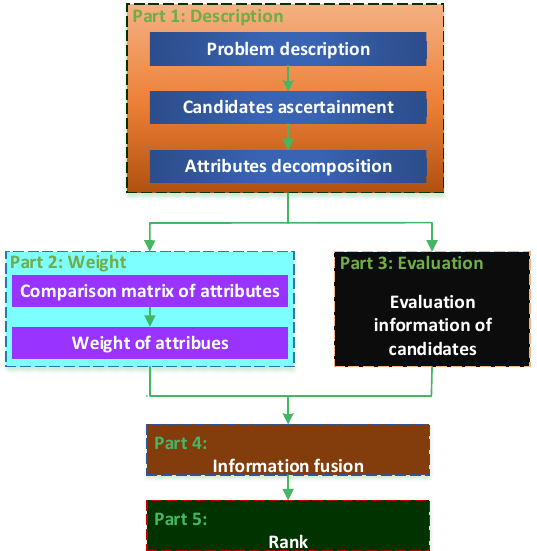
Figure 3. The model of